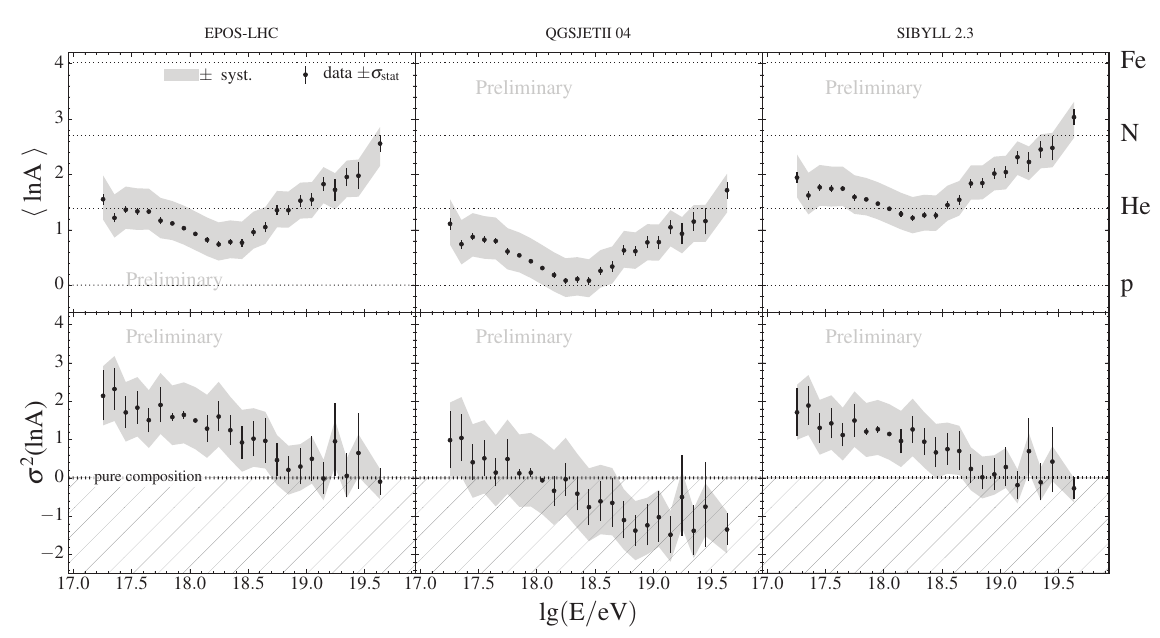
Figure 1. The mean (top) and the variance (bottom) of ln A estimated from data with the hadronic interaction models EPOS-LHC (left), QGSJetII-04 (middle) and Sibyll2.3 (right).